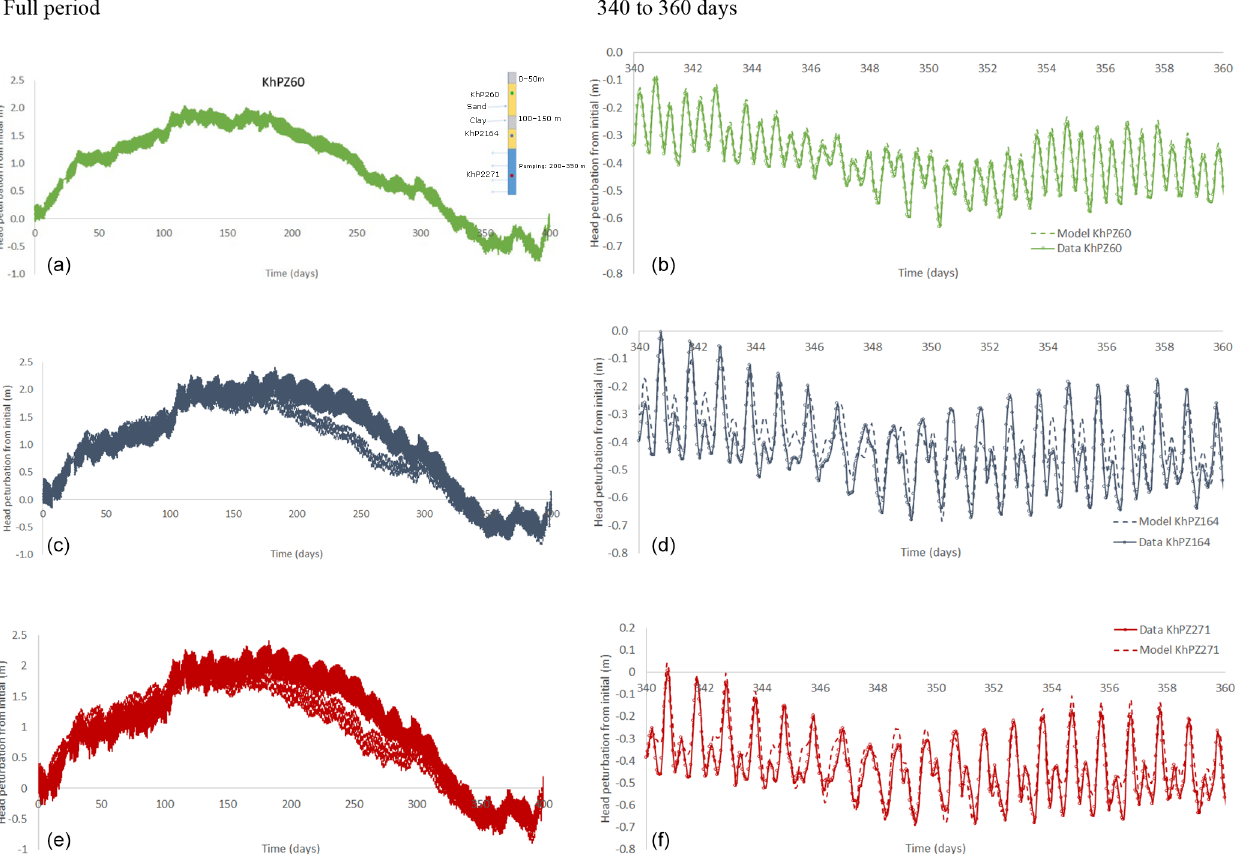
Figure 6. Khulna: comparison of observed heads (solid lines) and simulated heads (dashed lines), starting 27 April 2013, for the WT upper boundary condition ( S y = 0 . 4). The x axis is time in days. The surface loading is set equal to the observed head in KhPZ60, and the surface head is set to the observed head in KhPZ60 divided by S y . The pumping rate is 2.4ma − 1 for 12h of each day, switching on at 05:45 (Bangladesh Standard Time). Panels (a, b) are KhPZ60 (green), panels (c, d) are KhPZ164 (blue), and panels (e, f) are KhPZ271